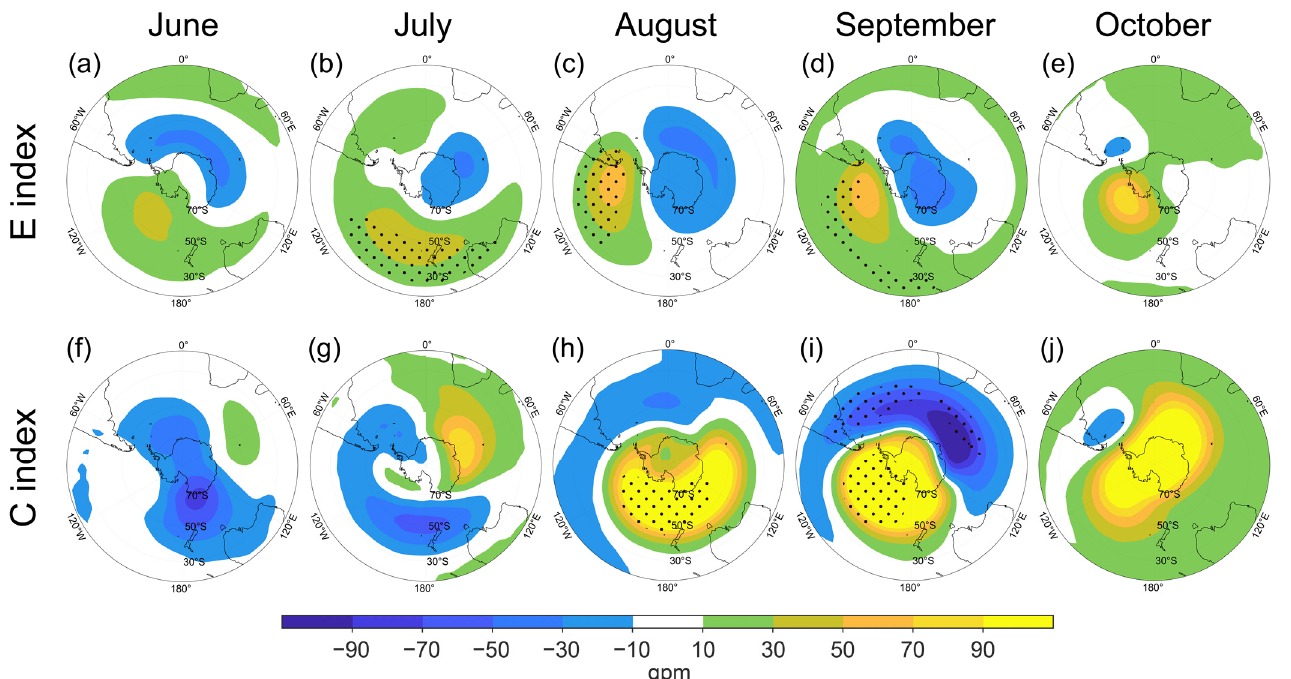
Figure 9. Regression of geopotential height anomalies at 10 hPa onto ( a – e ) E index and ( f – j ) C + index from June to October. Dotted areas represent statistically significant values at a 90% confidence level. Contour interval is 20 gpm. The outermost latitude is 20° S.